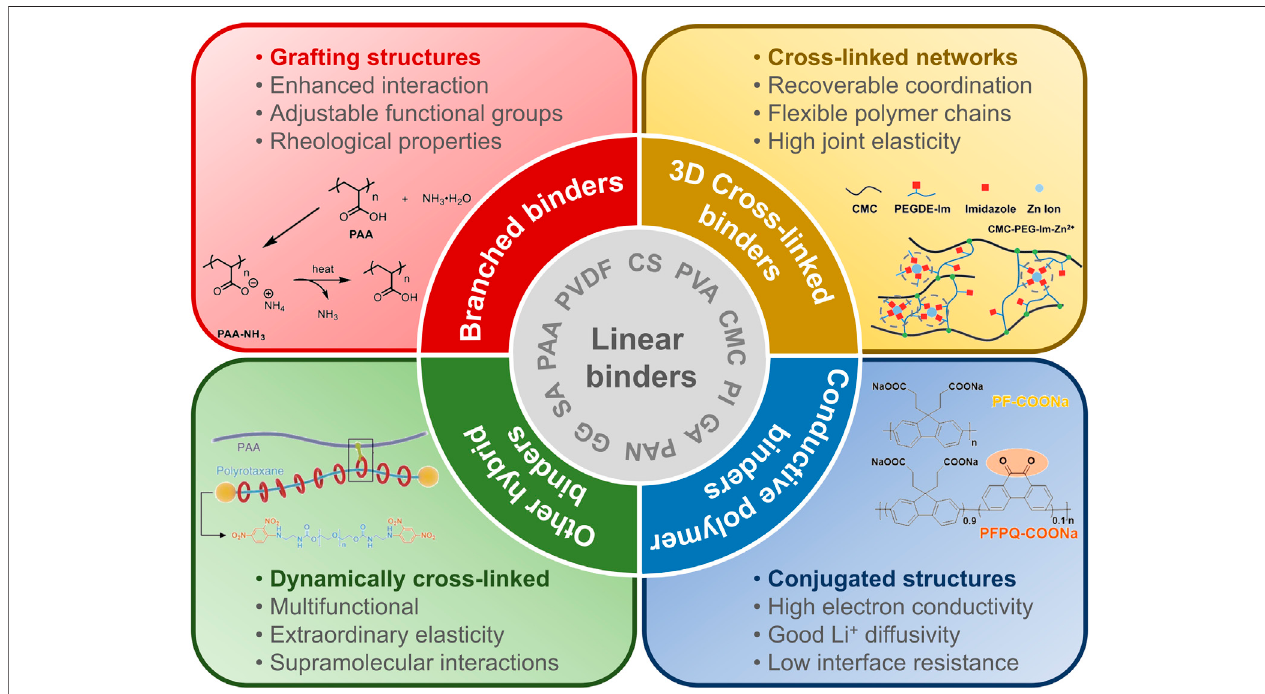
FIGURE 1 | An overview of various binders for Si-based anodes based on polymer structures. Basically, binders are divided into linear and hybrid structures (e.g., branched, 3D cross-linked, conjugated, dynamically cross-linked, and others). The inserted graphics are adapted with permission from Choi et al., (2017); Zhao et al., (2018); Shi et al., (2020); and Kim et al., (2021).